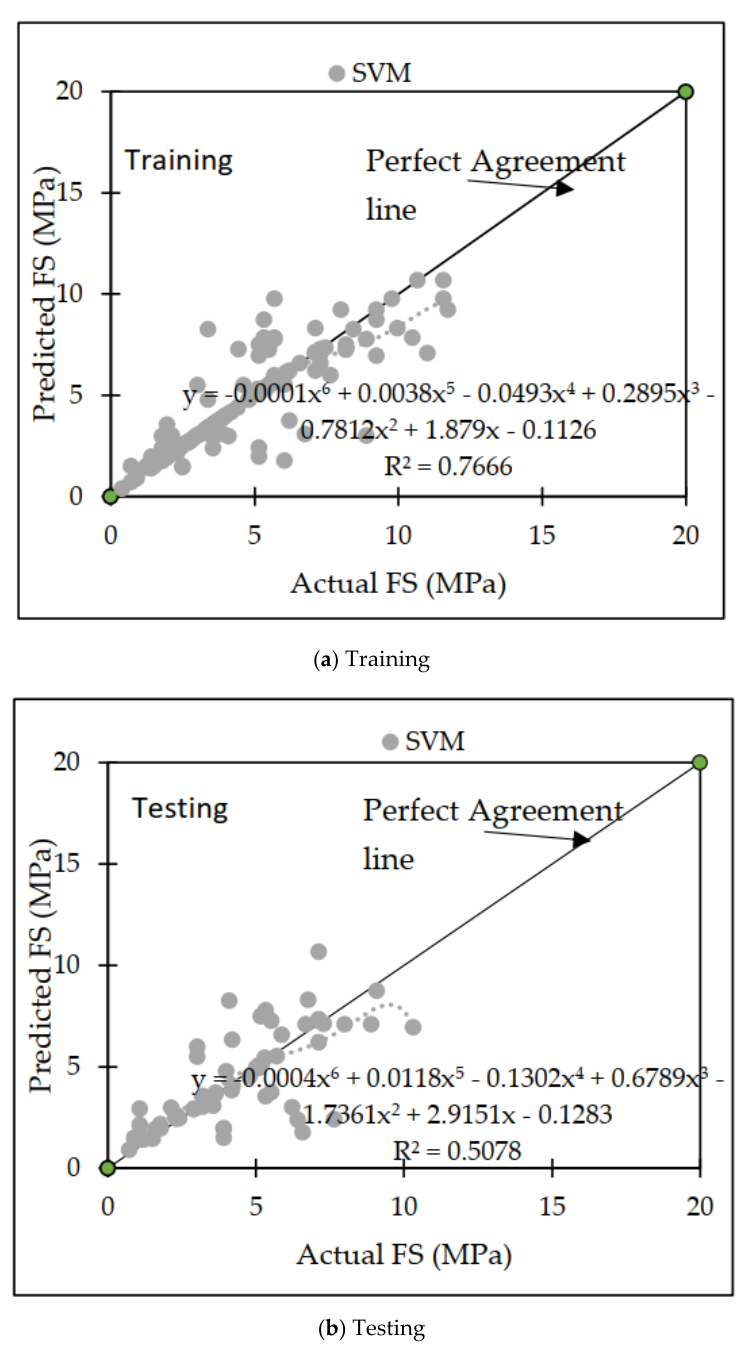
Figure 7. The scatter graph shows SVM-predicted and observed FS values.